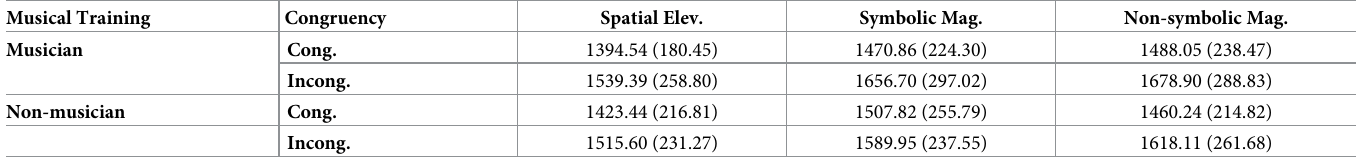
The mean scores (SD) for LISAS are shown in Table 2. The results of a mixed ANOVA indi- cated statistically significant main effects for congruency ( F (1,42) = 80.09, p < .001, η p 2 = .656), and for stimulus category ( F (2,84) = 35.99, p < .001, η p 2 = .461), but not for musical training group ( p = .79). In particular, LISAS scores were smaller for congruent ( M = 1457.49) Table 2. Mean linear integrated speed-accuracy scores (SD) and means (SD) for spatial elevation, non-symbolic magnitude, and symbolic magnitude categories, in both, congruent and incongruent conditions. Musical Training Congruency Spatial Elev. Symbolic Mag. Non-symbolic Mag. Musician Cong. 1394.54 (180.45) Non-musician